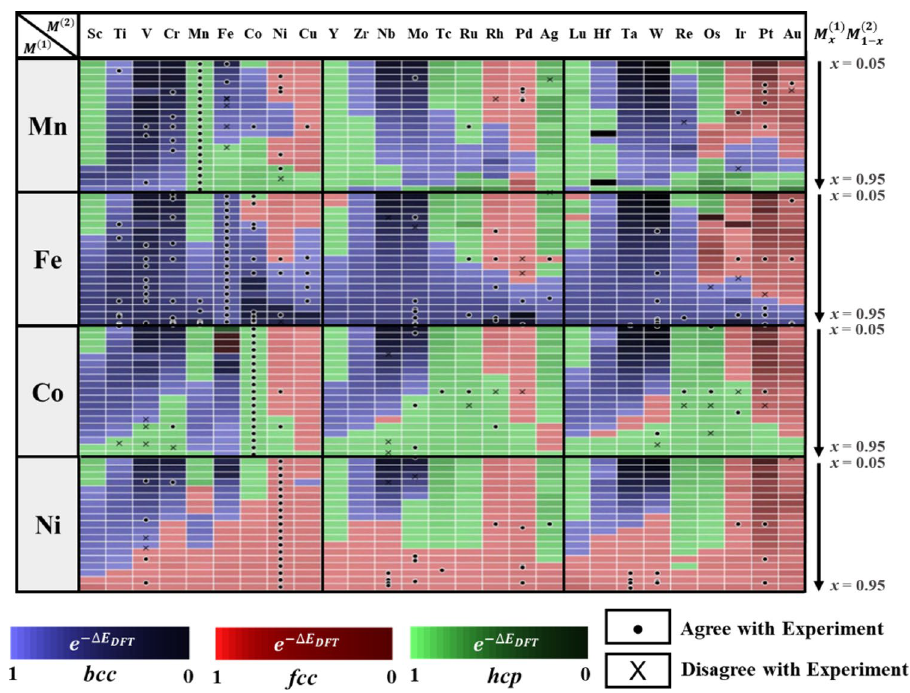
( 1 ) ( 2 ) M ( 1 ) = Mn, Fe, Co, and Ni; M ( 2 ) = TM) generated from DFT Figure 2. Binary alloy dataset of M x M 1 − x ( calculation. bcc , fcc , and hcp structures are denoted in blue, red, and green, respectively. The lowest energy phase is denoted as a stable phase and has the second-lowest energy used as a meta-stable phase. The energy